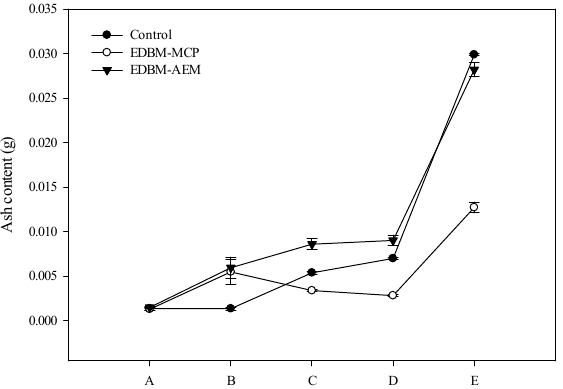
Figure 7. Ash content (g) evolution during three different processes. Letters A to E refer respectively to hemoglobin solution, conductivity adjustment (only for EDBM-MCP and EDBM-AEM), end of acidification, end of hydrolysis and reaction stop.